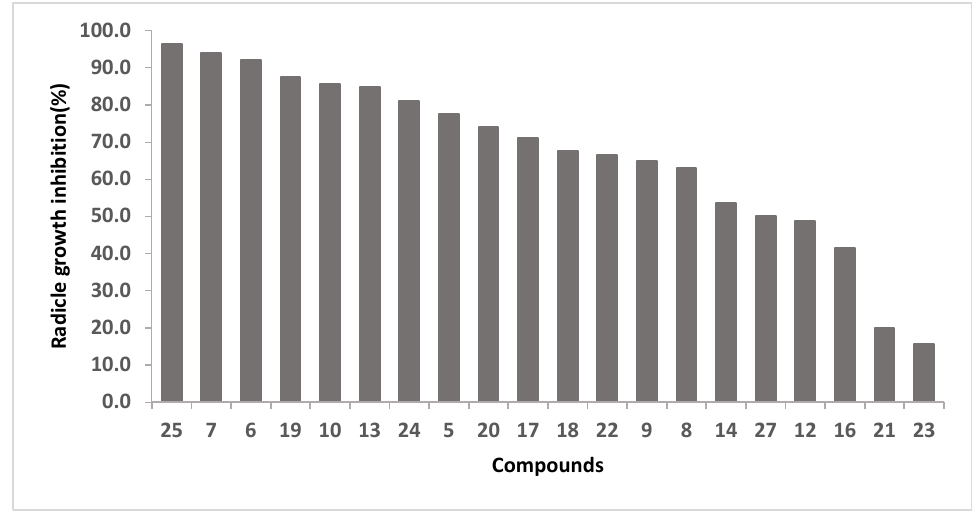
Figure 3. Radicle growth inhibition (%) of compounds at 67 μ g/mL, positive control : S -metolachlor, 100% inhibition radicle growth at 2 . 1 μ g/mL.